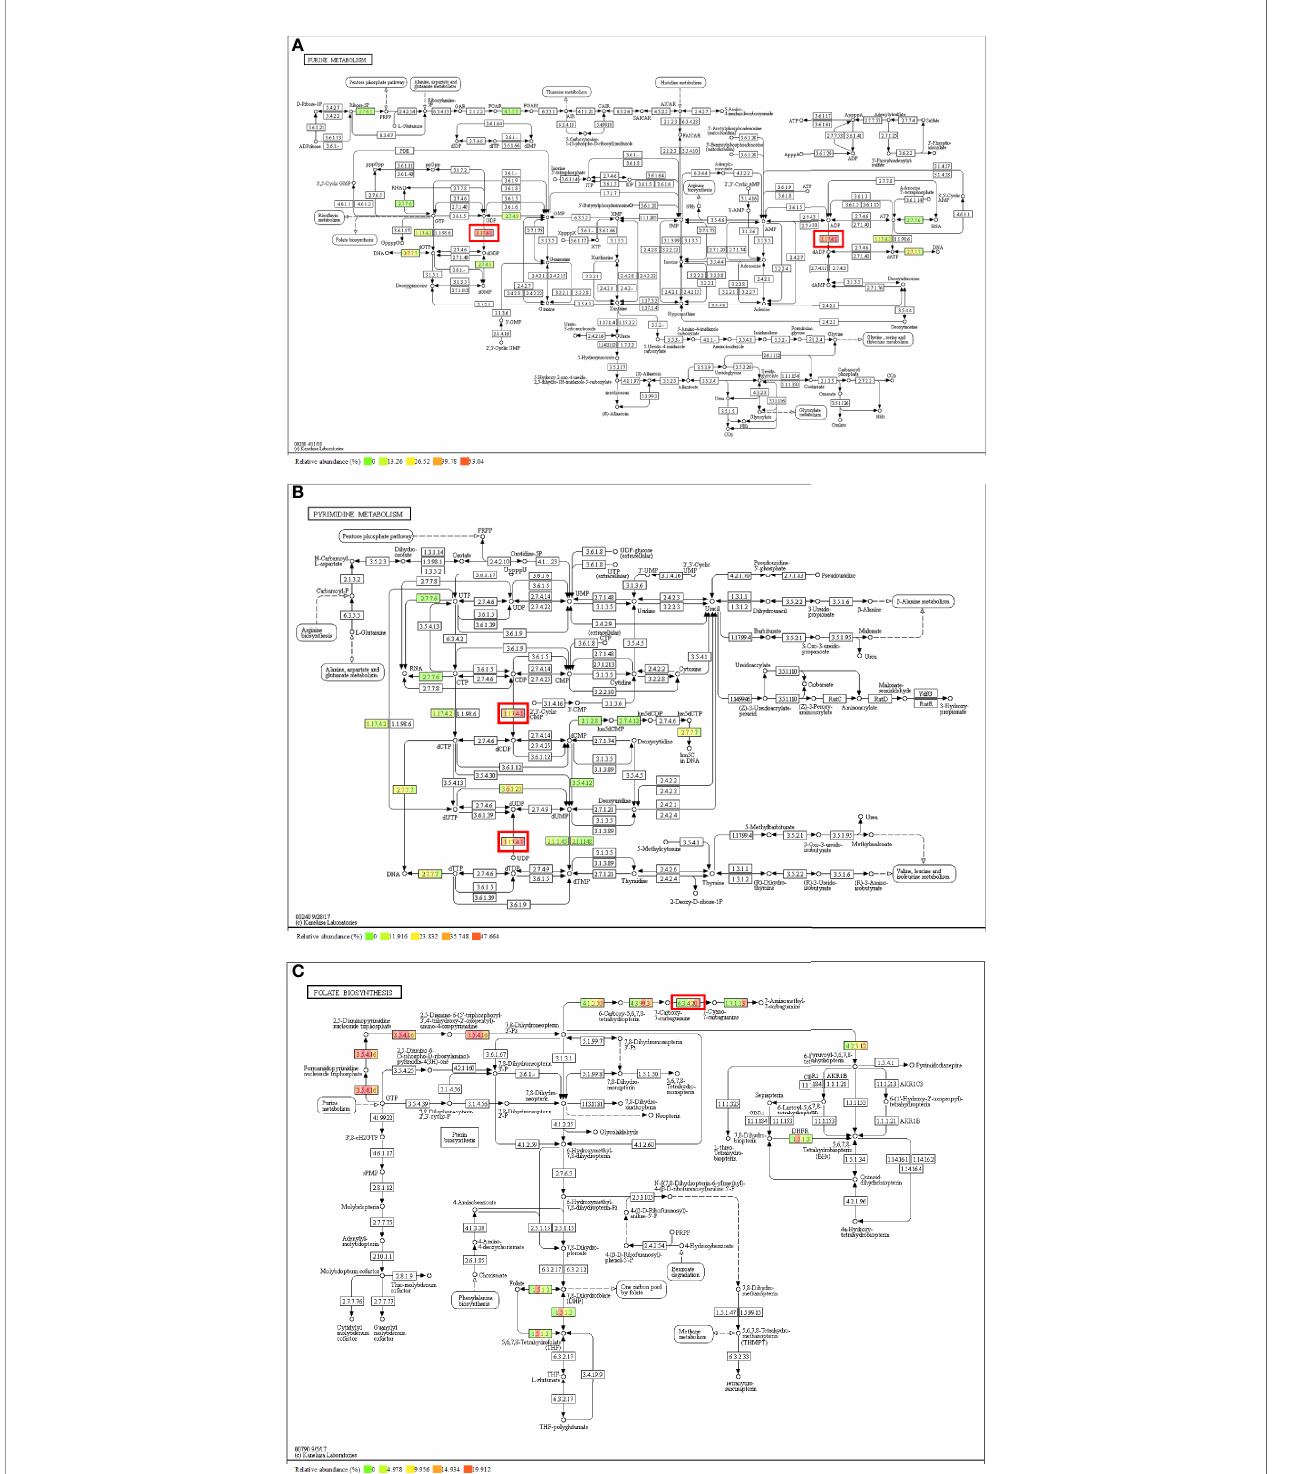
FIGURE 5 | Metabolism pathway and annotated enzyme of the correlated KO genes. (A) Purine metabolism and [EC:1.17.4.1]; (B) Pyrimidine metabolism and [EC:1.17.4.1]; (C) Folate biosynthesis and